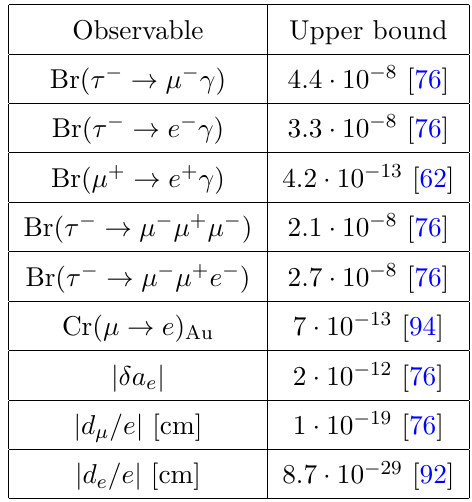
Table 4. The best-(cid:12)t values and 1 (cid:27) errors for the leptonic mixing parameters and mass-squared di(cid:11)erences from the NuFIT group (NuFIT 3.0, November 2016) [59{61]. See also the discussion in section 2.3. Note that we use symmetric lower and upper errors (choosing the largest of the two when di(cid:11)erent asymmetric errors are present). Here (cid:1) m 2 for IO. Note that for sin 2 (cid:18) 23 there are two minima in their distribution [60, 61] for both orderings, corresponding to the (cid:12)rst and second octants. For (cid:14) the distribution is also not (cid:31) 2 distributed. Therefore, for sin 2 (cid:18) 23 and (cid:14) , the two-dimensional complete distribution is used.